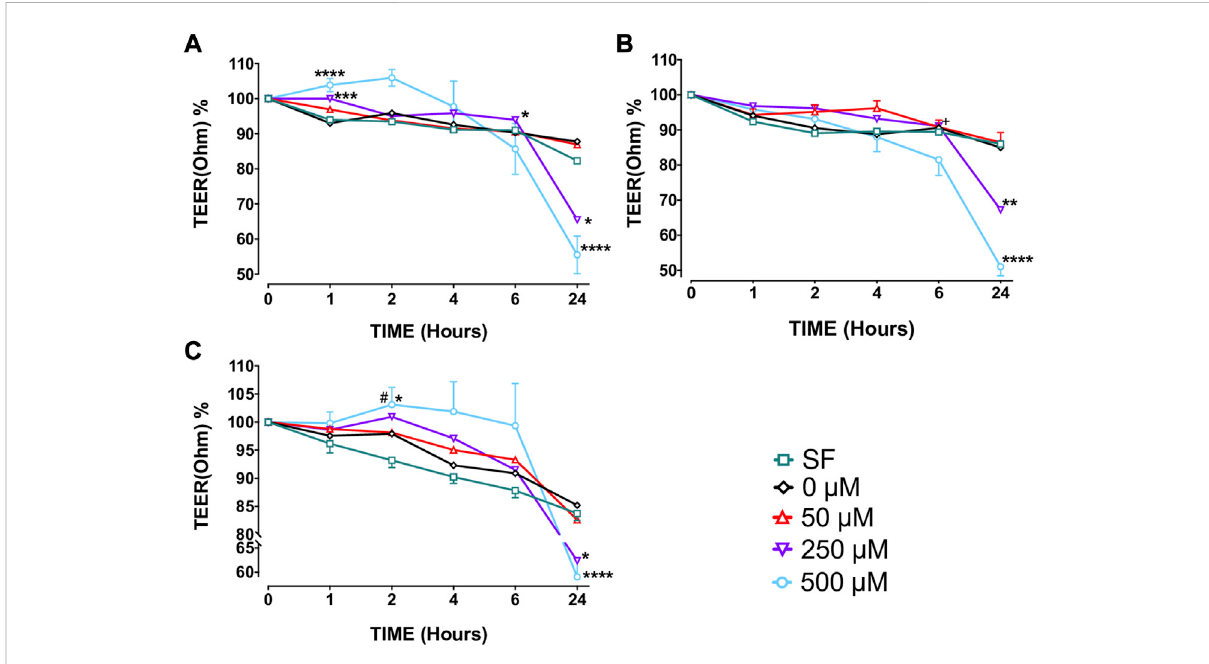
FIGURE 2 The effect of capsaicin on transepithelial electrical resistance (TEER) of bronchial epithelial cell (BEC) cultures of non-smokers (A) , smokers (B) and patients with COPD (C) Mean±SEM is displayed for non-smoker ( N = 5), smoker ( N = 13) and patients with COPD ( N = 7). (* p < 0.05, ** p < 0.01, *** p < 0.001; **** p < 0.0001 vs. 0 μ M capsaicin; + p < 0.05 vs. non-smokers, # p < 0.05 vs. smokers). SF, serum free treated cells; 0 µM indicates ethanol, solvent for